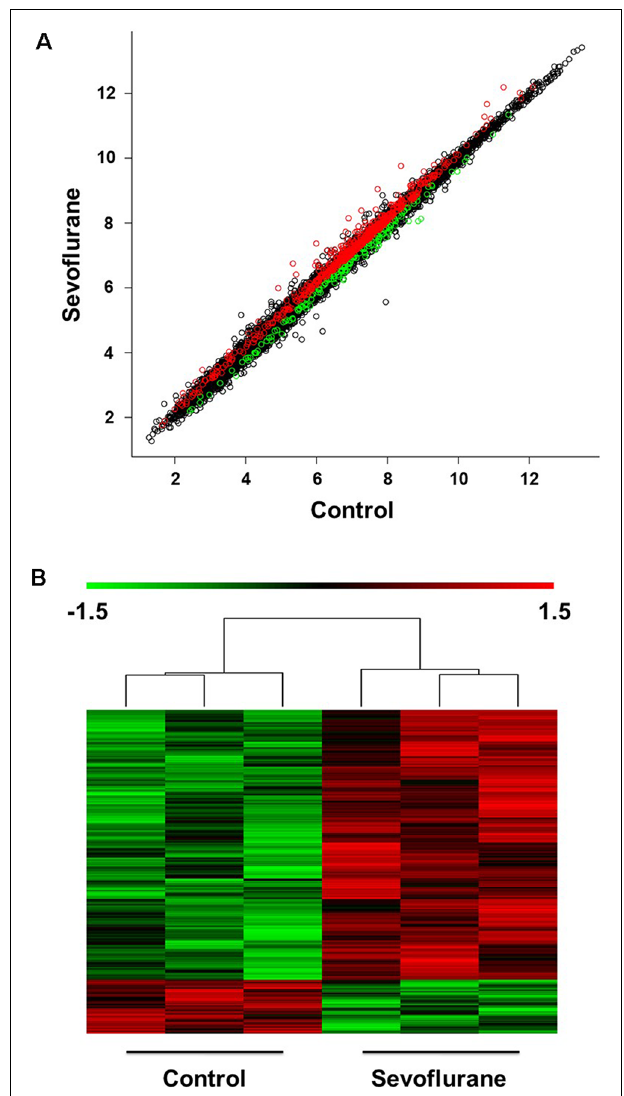
FIGURE 2 | Differential expression of mRNAs in the hippocampus ( n = 6). (A) The scatter plot indicated the variation in hippocampal gene expressions between the sevoflurane group and control condition. The values corresponding to the X- and Y-axes in the scatter plot are the normalized signal values of the control and sevoflurane groups (log 2 scaled). (B) Hierarchical cluster analysis showed differentially expressed genes between groups from microarray analysis ( p <